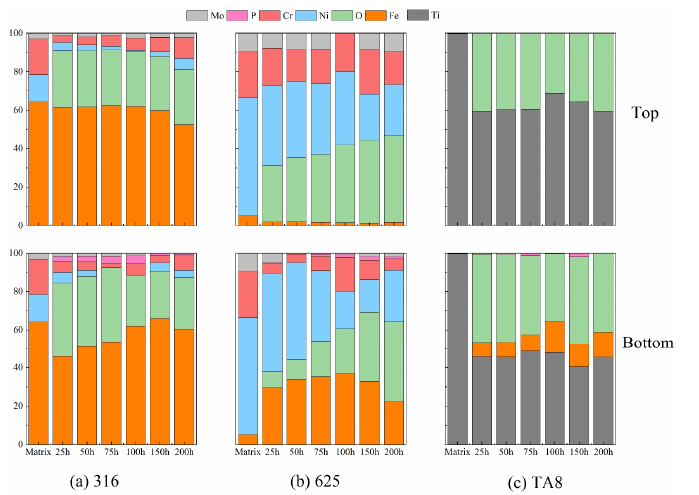
Figure 4. The main elements compositions of the oxide films formed on ( a ) 316 SS at the top and bottom reaction tube, ( b ) Alloy 625, ( c ) TA8 after exposure to SCW at experiments Run-1 to Run-6.